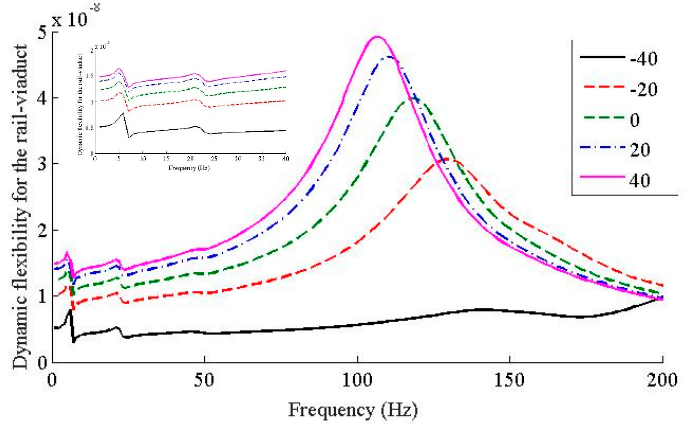
Figure 7. Dynamic flexibility amplitude of the rail under − 40, − 20, 0, 20, and 40 °C.